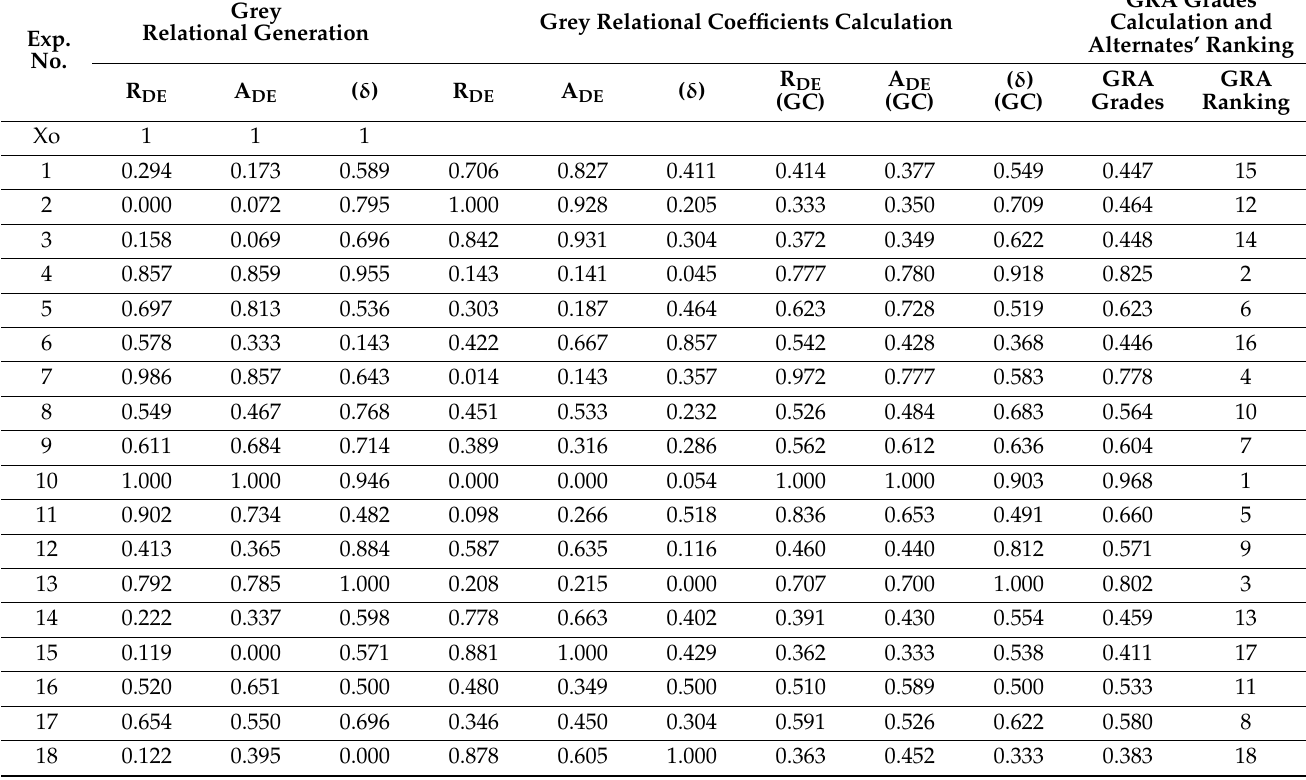
Table 5. Desired settings for R DE and A DE.